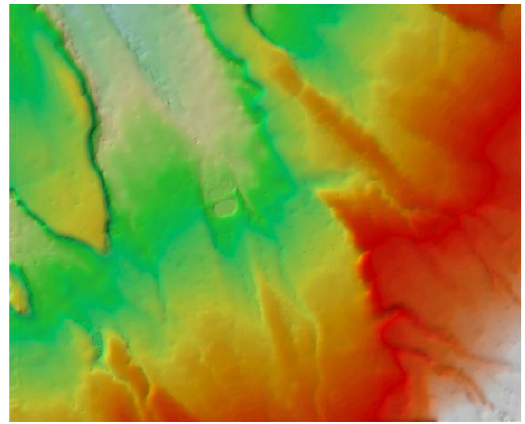
Figure 5 . Map: DX_I49G039026-DEM.